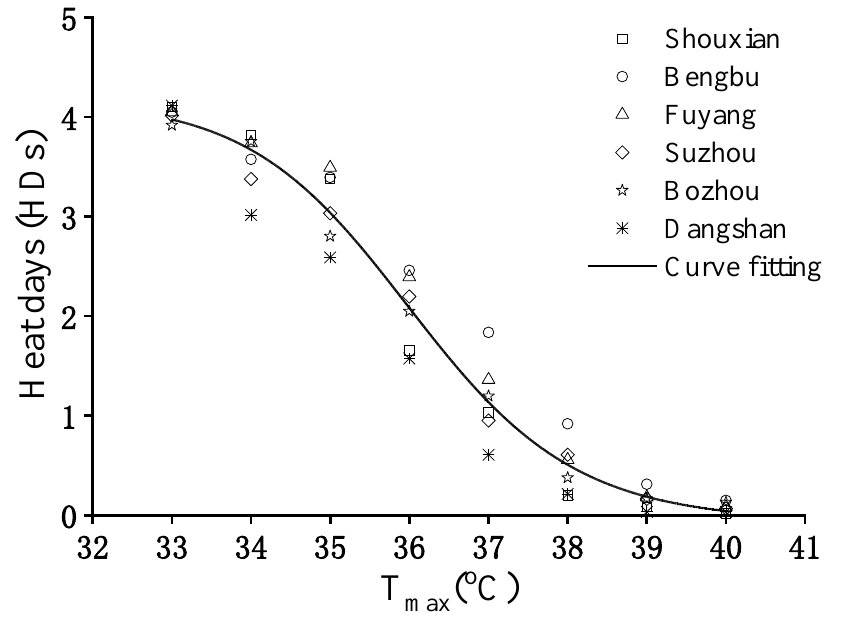
Figure 4. The occurrence frequency and curve fitting of days with T max greater than the specified temperature thresholds during the flowering stage for six sites, i.e., Shouxian (square), Bengbu (circle), Fuyang (triangle), Suzhou (rhombus), Bozhou (pentacle), and Dangshan (asterisk), on Huaibei Plain, China.